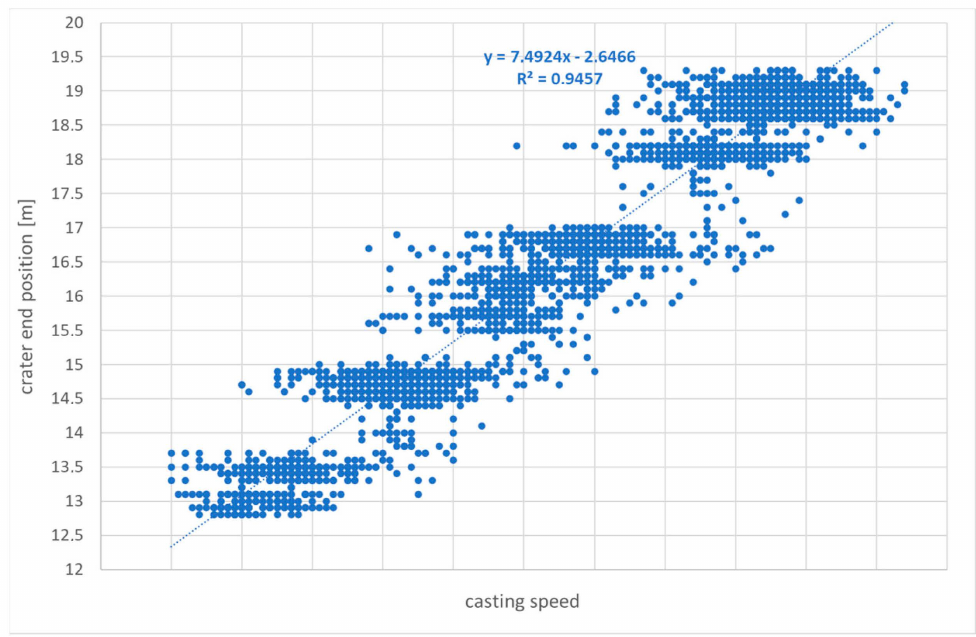
Figure 17. Crater end position vs. casting speed for sequence casted at ESF and simulated with full 3D online temperature and solidification model.